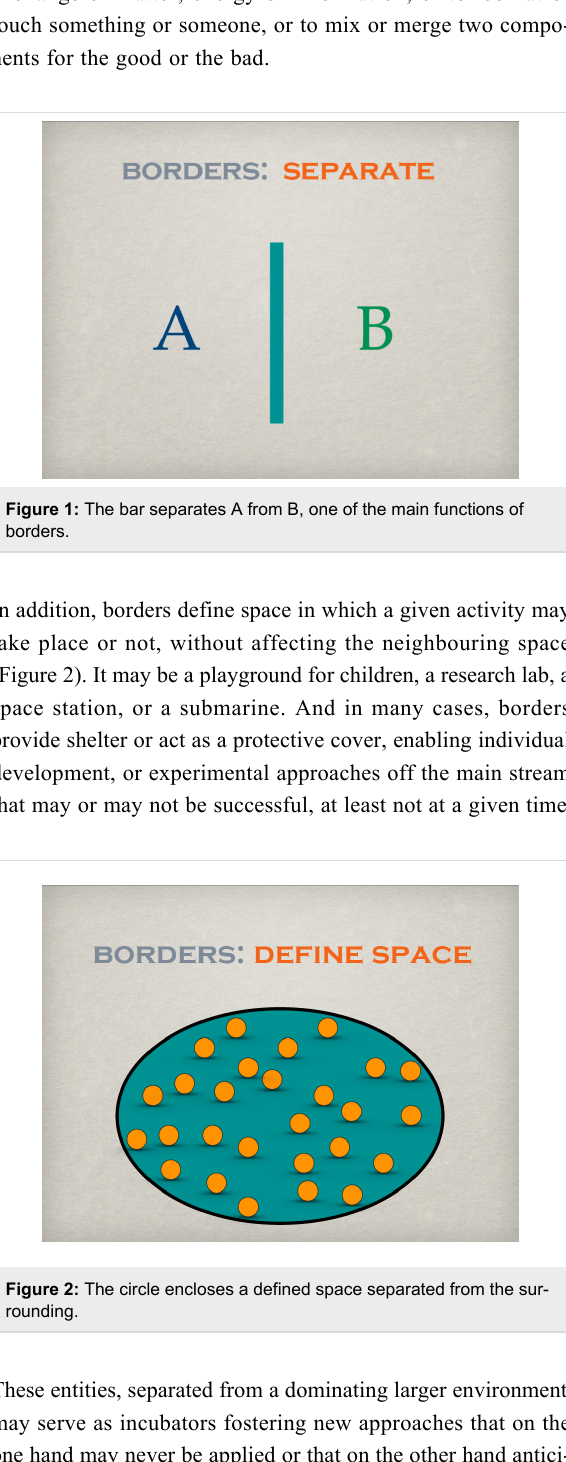
These entities, separated from a dominating larger environment, may serve as incubators fostering new approaches that on the one hand may never be applied or that on the other hand antici- pate developments becoming relevant at a much later stage, often disconnected from the original work. We know a large number of inventions, drafts of machinery or theories that were commonly accepted, received attention, or became important only years or even centuries after their conception. In